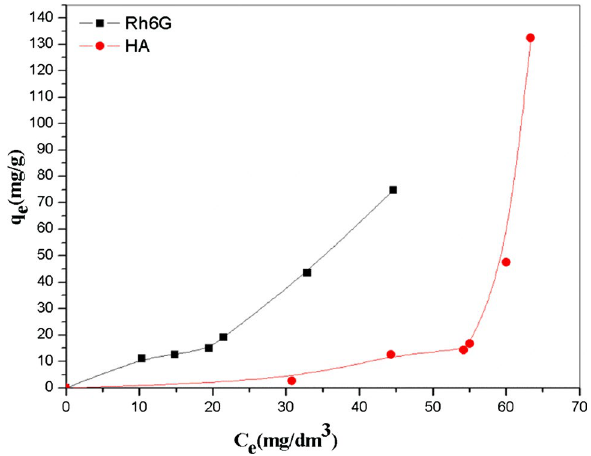
Fig. 10 Equilibrium adsorption data for Rh6G and HA on